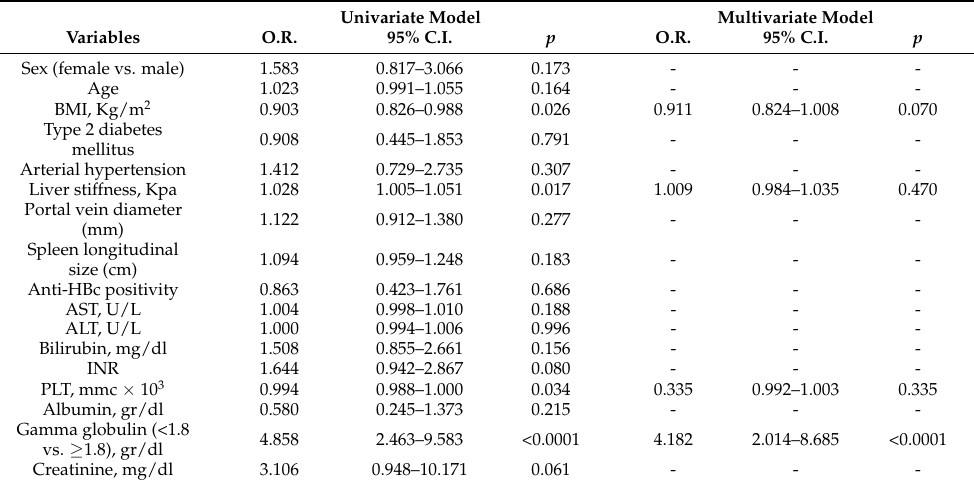
Table 4. Univariate and multivariate logistic regression analyses of different predictors variables of hepatocellular carcinoma (HCC).